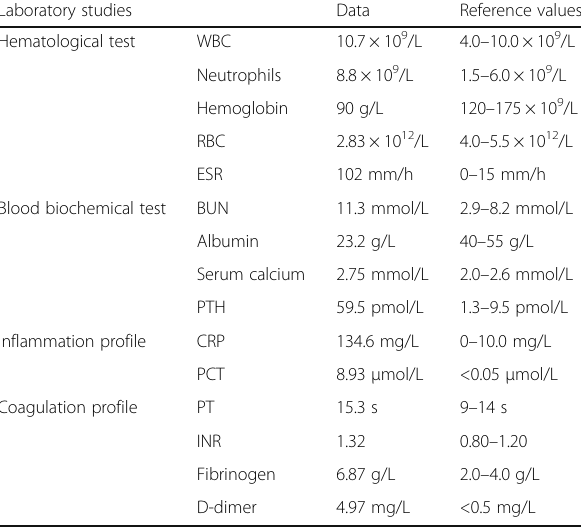
Table 1 Significant abnormal laboratory data Laboratory studies